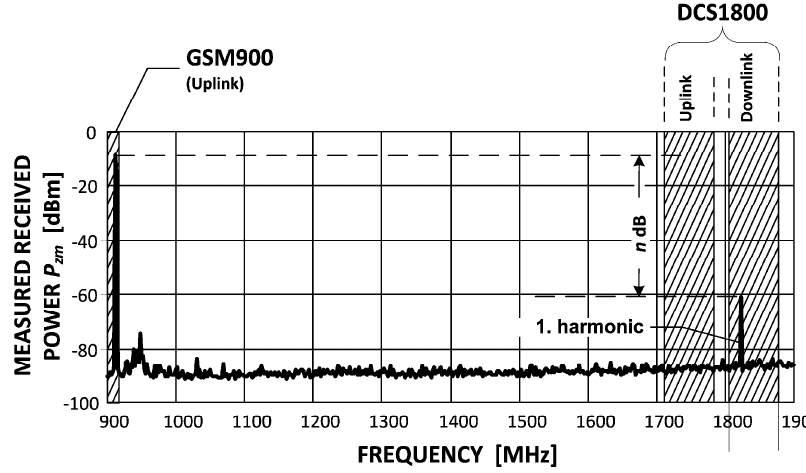
Figure 12. Radiated emission from the core GSM modem (core segment): the wanted signal and the undesirable 1st harmonic.